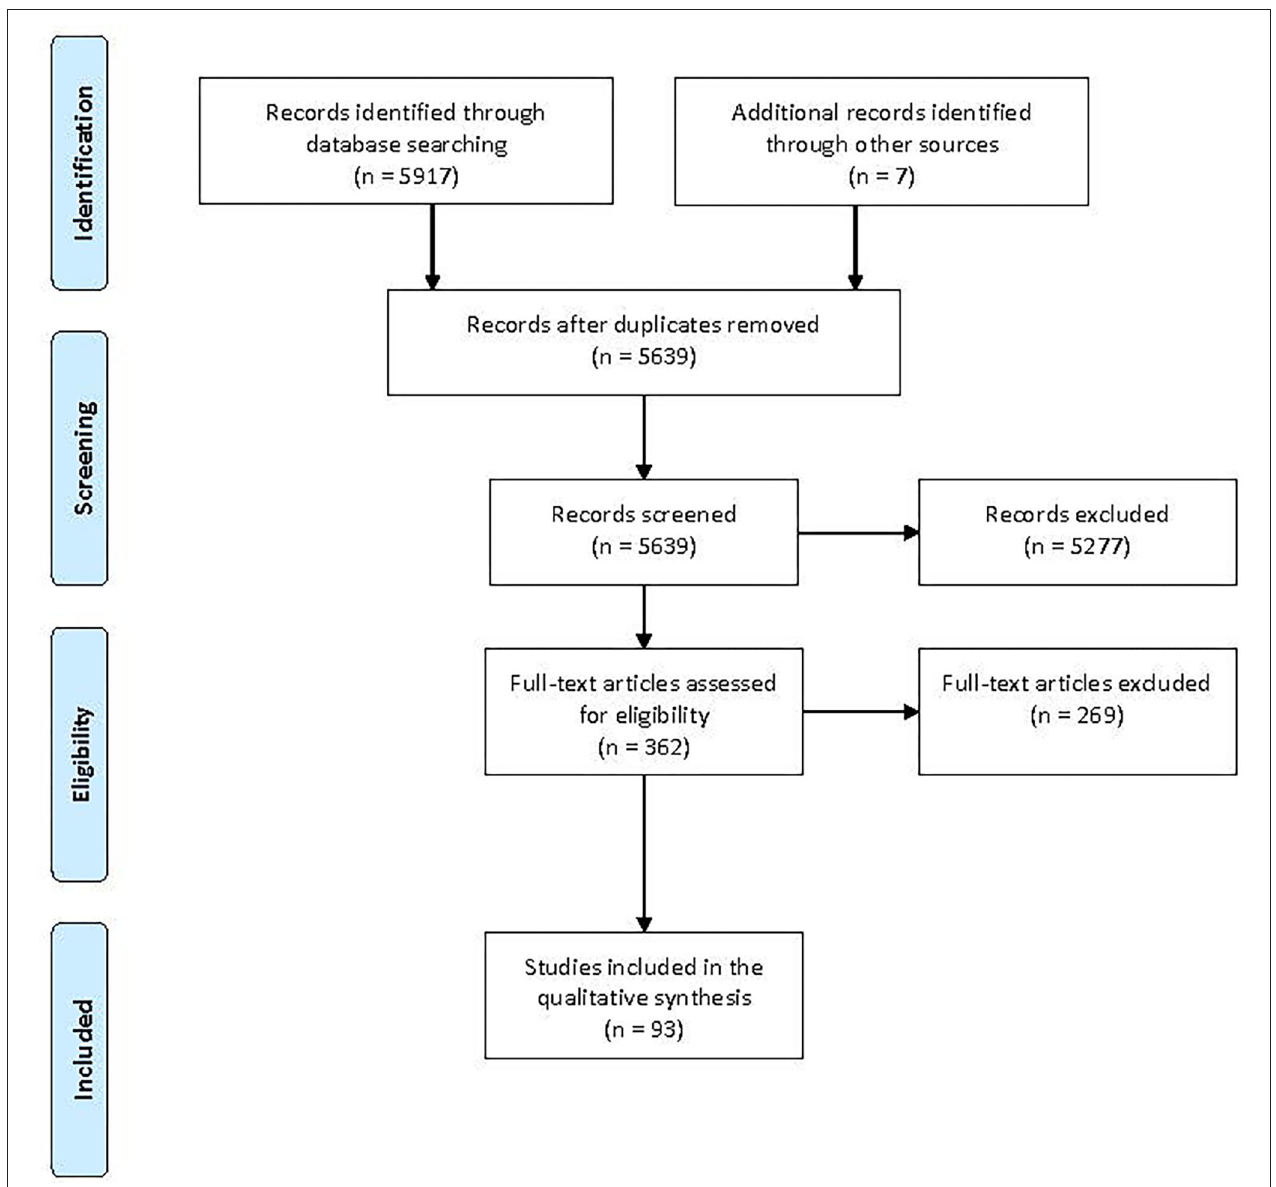
FIGURE 1 | PRISMA flowchart showing the selection of